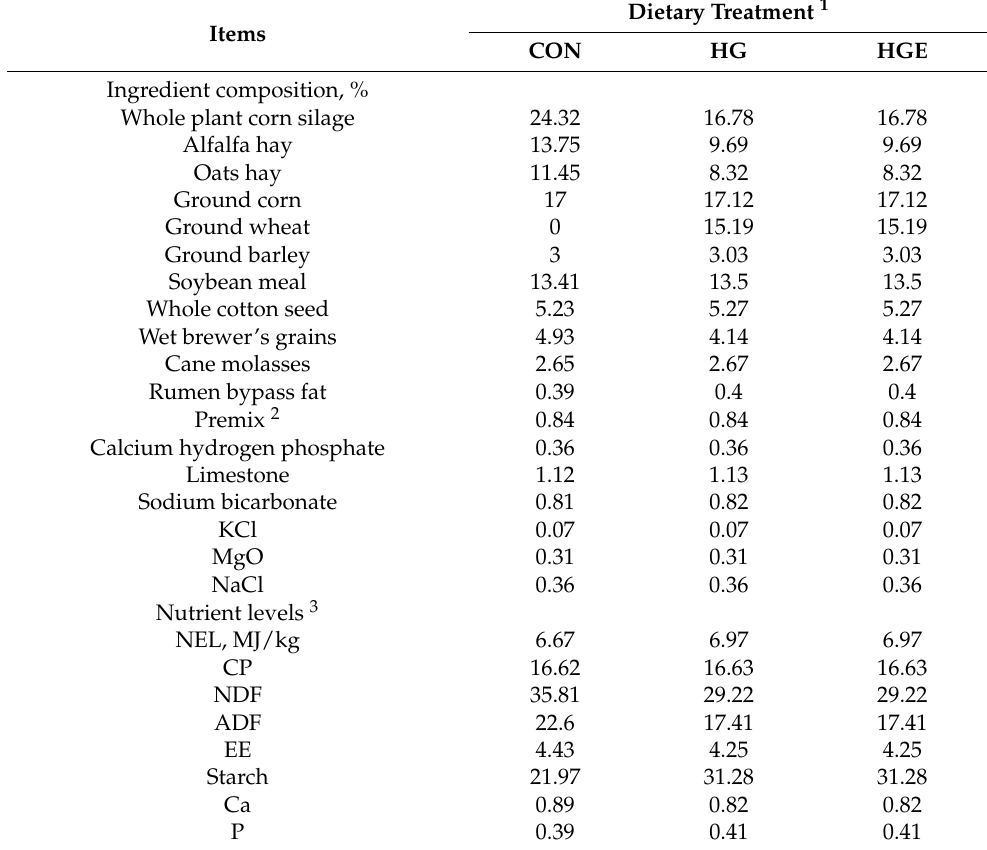
Dietary Treatment 1 CON HG